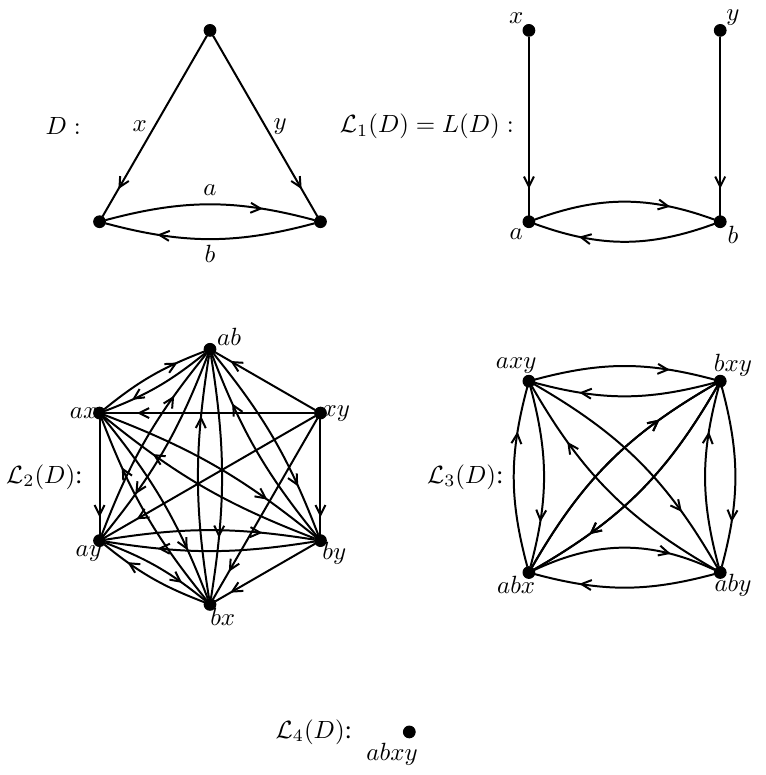
Figure 26: A digraph and its super line